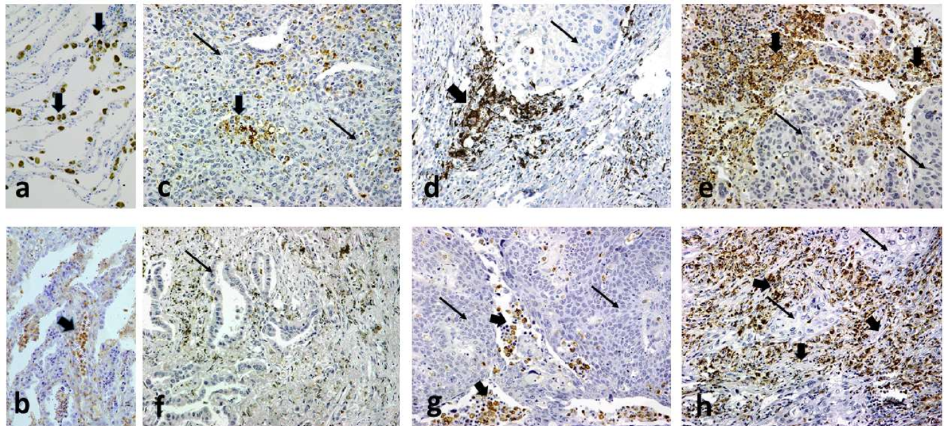
Figure 3. Immunohistochemical images of normal lung alveolar tissue showing presence of macrophages stained for CD68 ( a ) and SIRPAa ( b ). Typical immunohistohemical images of non-small cell lung carcinomas with ( c ) low infiltration of the tumor stroma by CD68+ macrophages (score 1); ( d ) medium infiltration of the tumor stroma by CD68+ macrophages (score 2); ( e ) intense infiltration of the tumor stroma by CD68+ macrophages (score 3); ( f ) lack of SIRP α + macrophages in the tumor stroma (score 0); ( g ) low infiltration of the tumor stroma by SIRP α + macrophages (score 1); ( h ) in- tense infiltration of the tumor stroma by SIRP α + macrophages (score 2). All images are shown at × 20 magnification. Thick arrows show areas of macrophage presence. As noted in all images CD68 and SIRP α were not expressed by cancer cells (thin